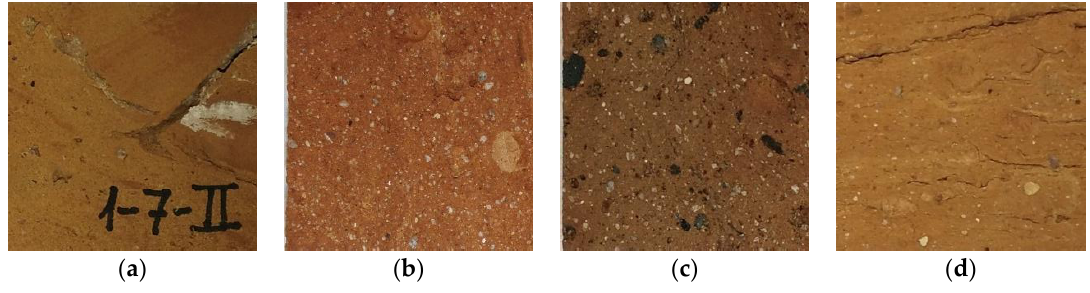
Figure 1. Brick classification based on macroscopic analysis: ( a ) G1; ( b ) G2; ( c ) G3; ( d ) G4.